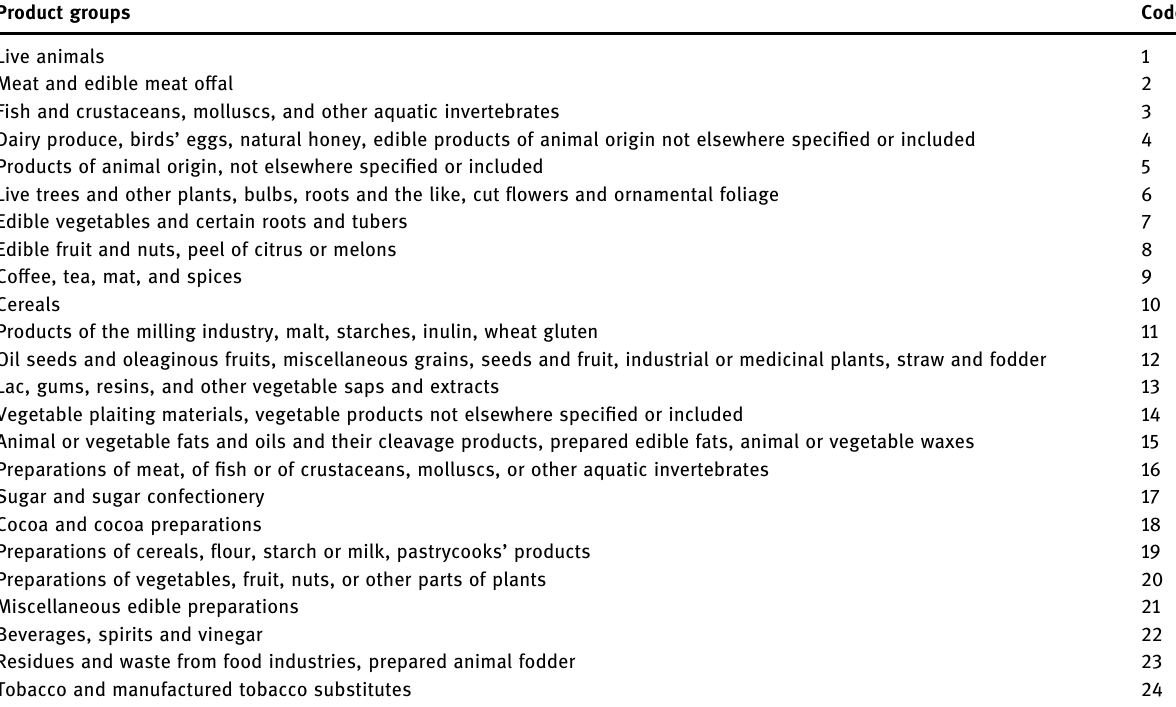
Table 1: Codes of product groups by HS - 2 classi fi cation Product groups